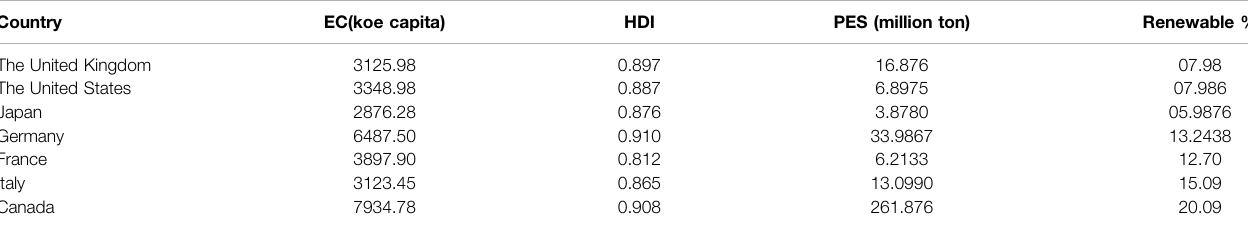
TABLE 1 | Average score of individual indicators. Country EC(koe